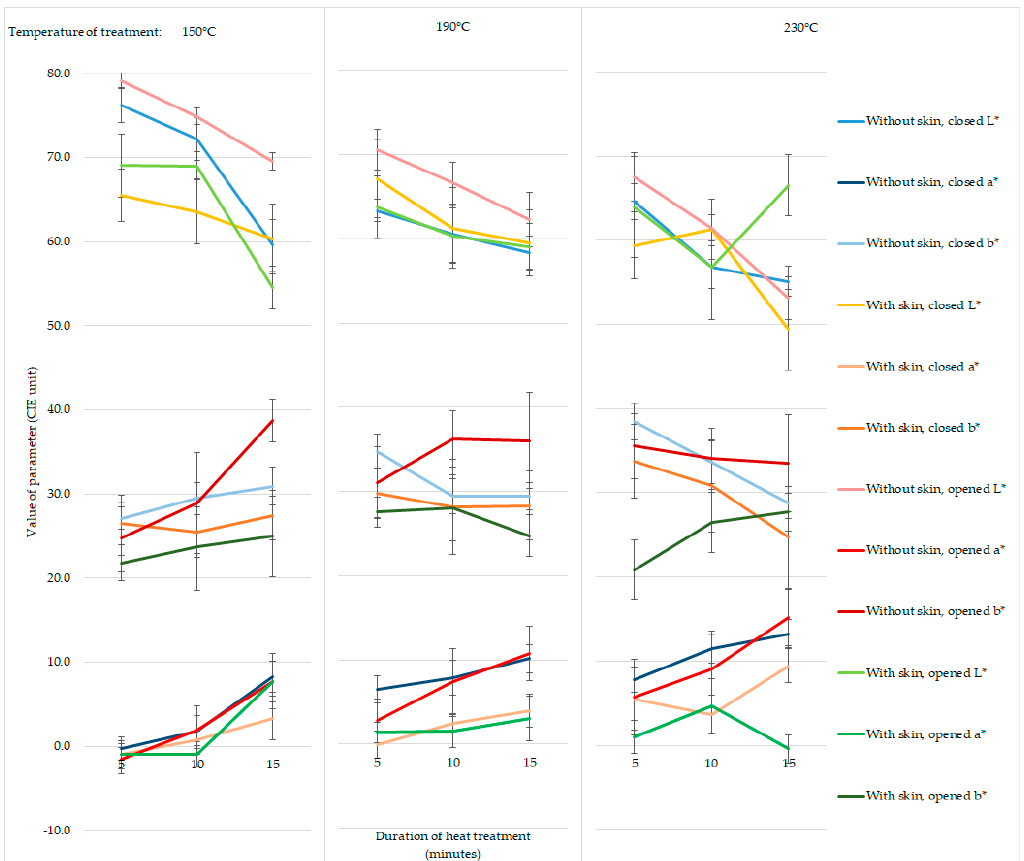
Figure 5. The changes of CIELAB (International Commission on Illumination) values (L*, brightness; a*, redness; b*, yellowness) by the heat treatment conditions: temperature, duration, presence of skin, and position of upper grill plate. The meaning of the values is explained in the section of materials and